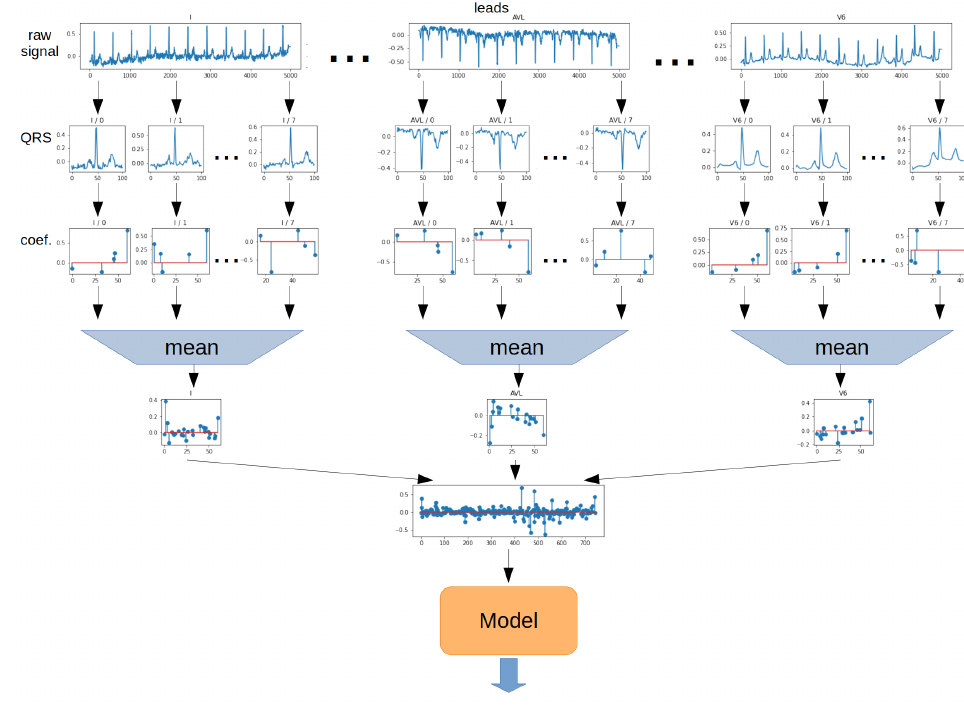
Figure 13. Aggregation